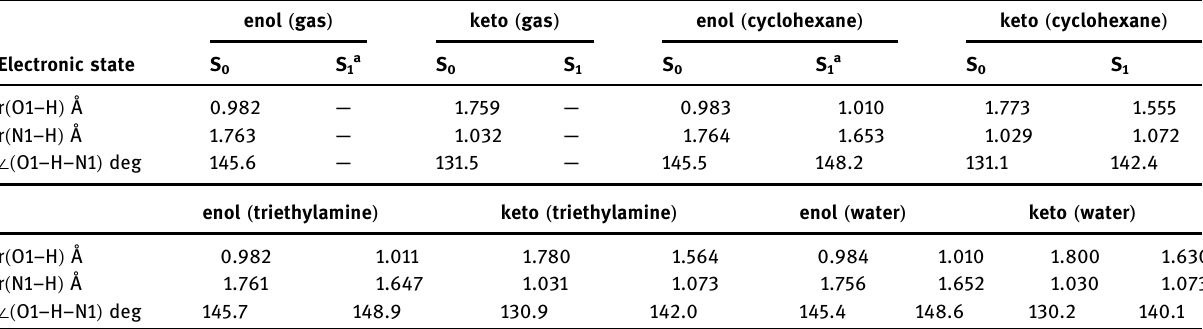
Table 1: The DFT/TDDFT optimized geometries in the various solvations enol ( gas